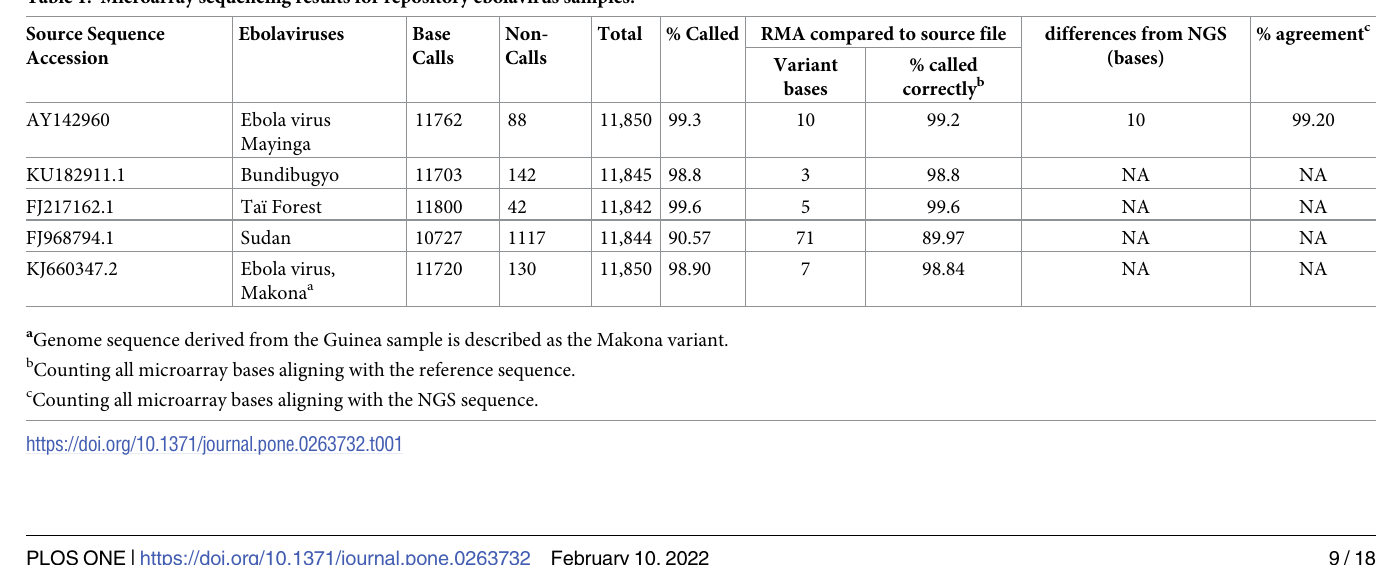
Table 1. Microarray sequencing results for repository ebolavirus